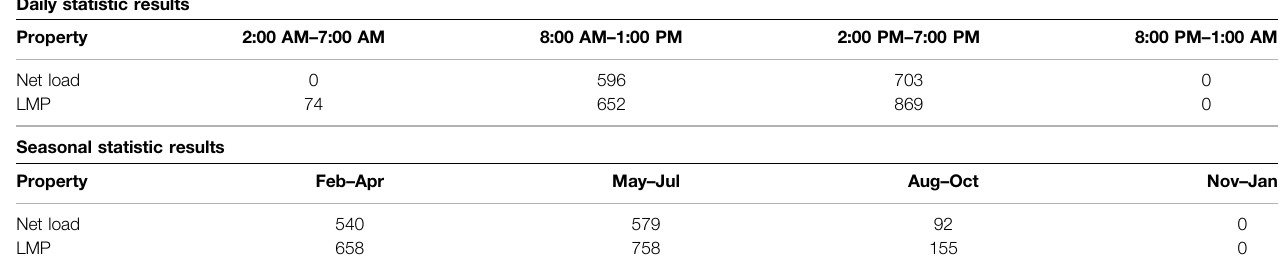
TABLE 3 | Daily and seasonal statistic results of number of hours of negative net load and zero LMPs. Daily statistic